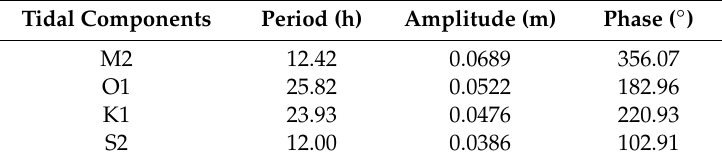
Table 2. Tidal components used for open boundary conditions.